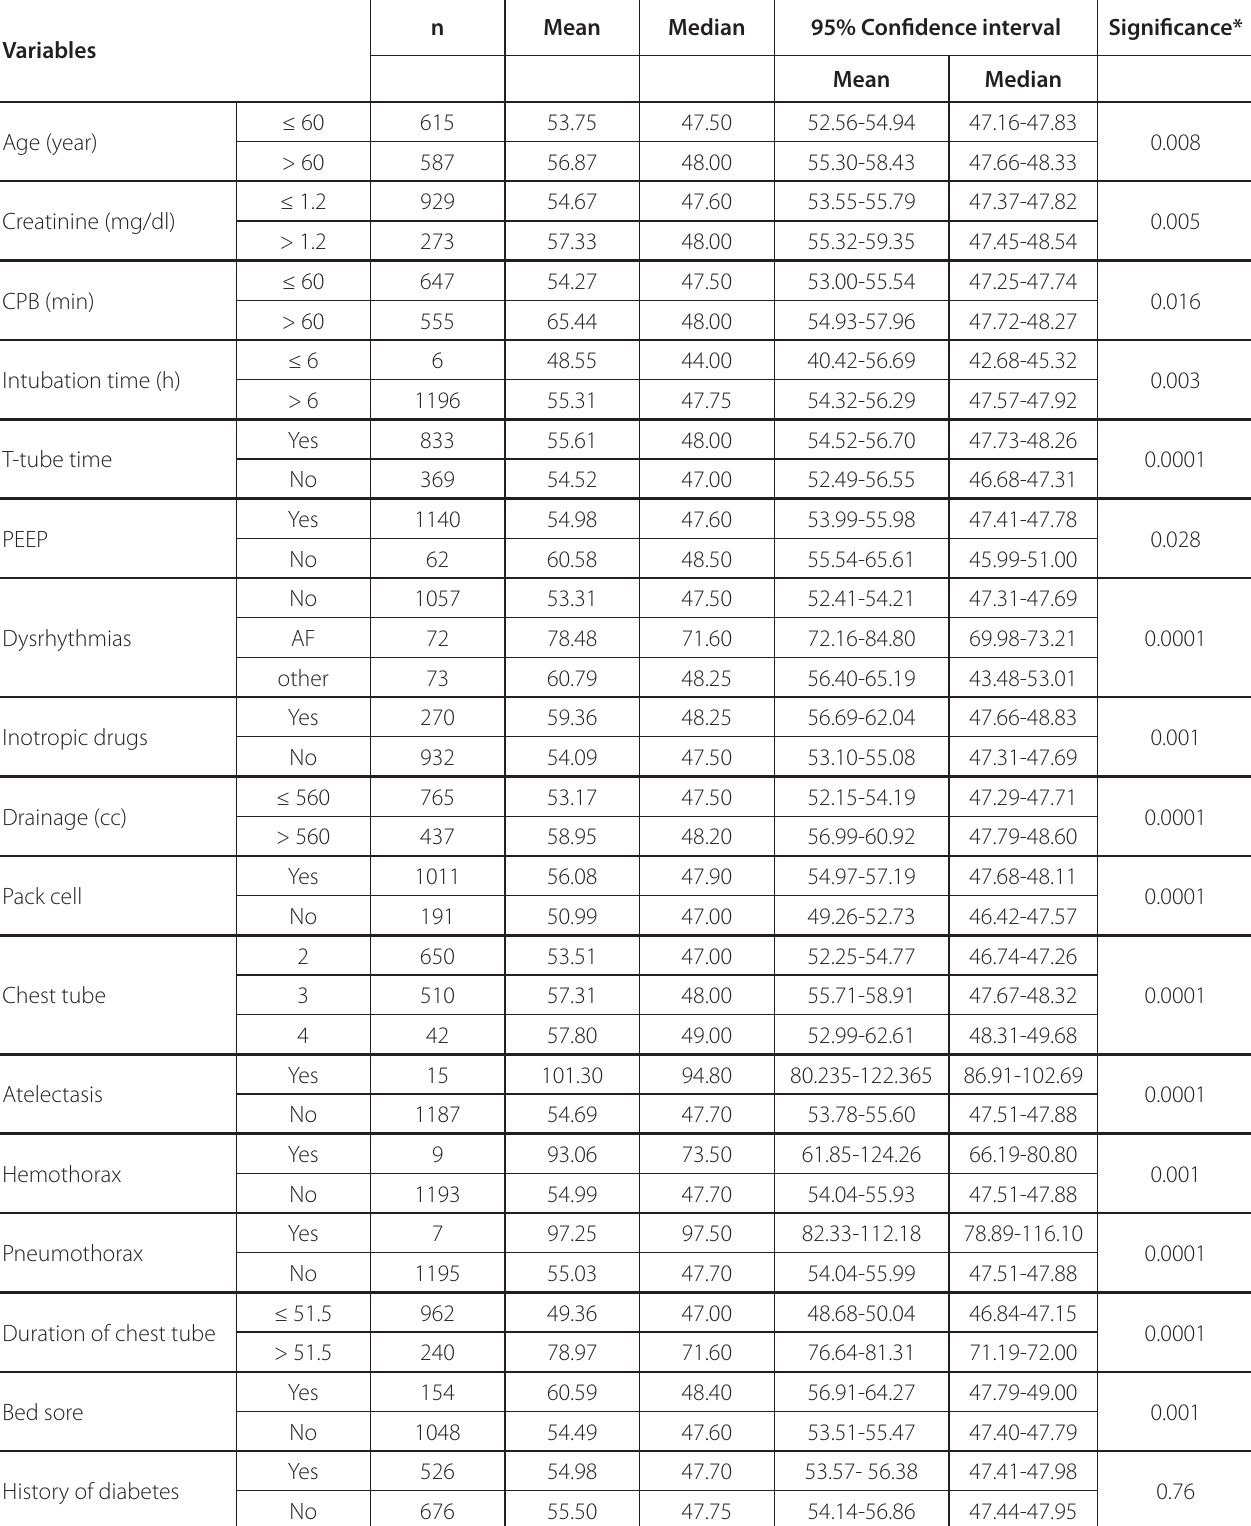
Table 1 . Comparison of the length of stay in the intensive care unit (hours) after coronary artery bypass grafting.